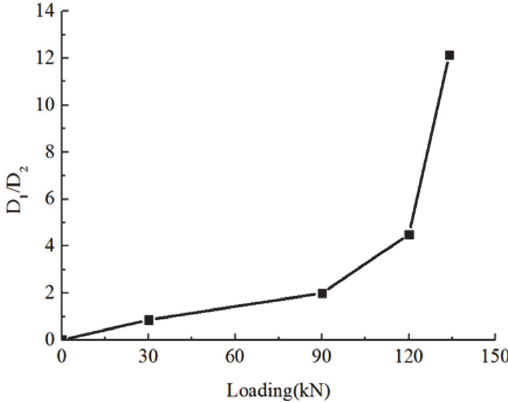
Figure 10: Loading-damage curve of concrete